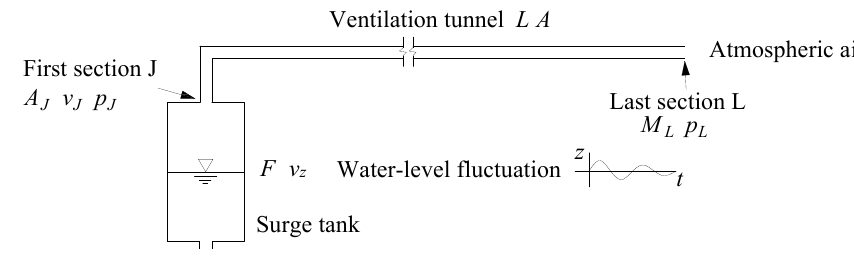
Figure 3. The boundary conditions of the first section of a ventilation tunnel.